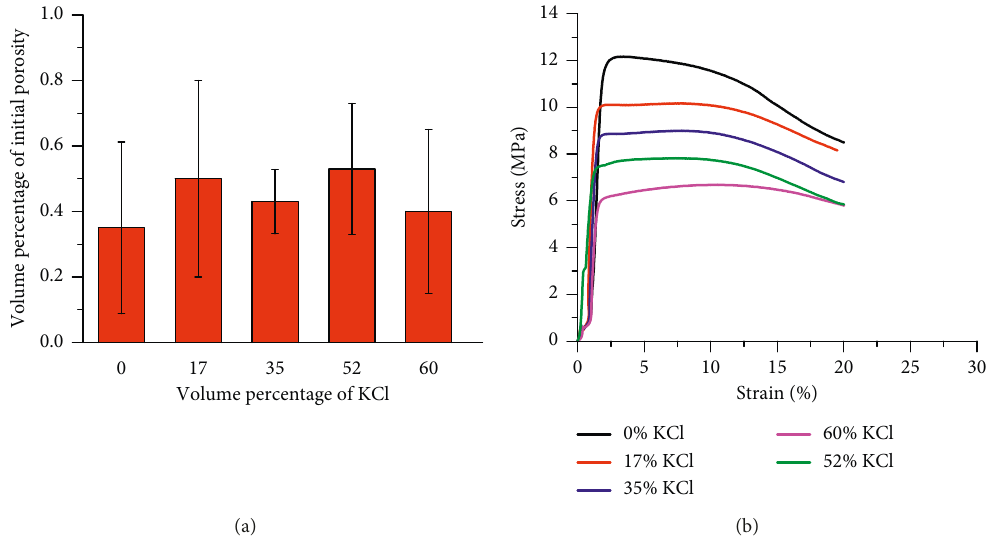
Figure 4: (a) The amount of initial porosity in the green samples with the space holder added; (b) the green strength of the samples with the space